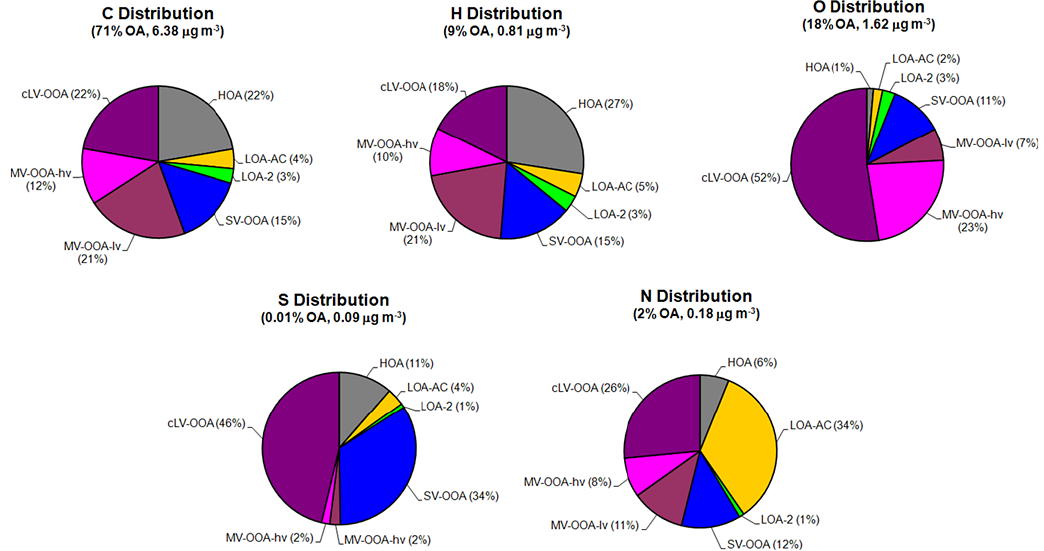
Fig. 8. Distribution of carbon, hydrogen, oxygen, sulfur, and nitrogen among OA components identified in the 7-component solution during